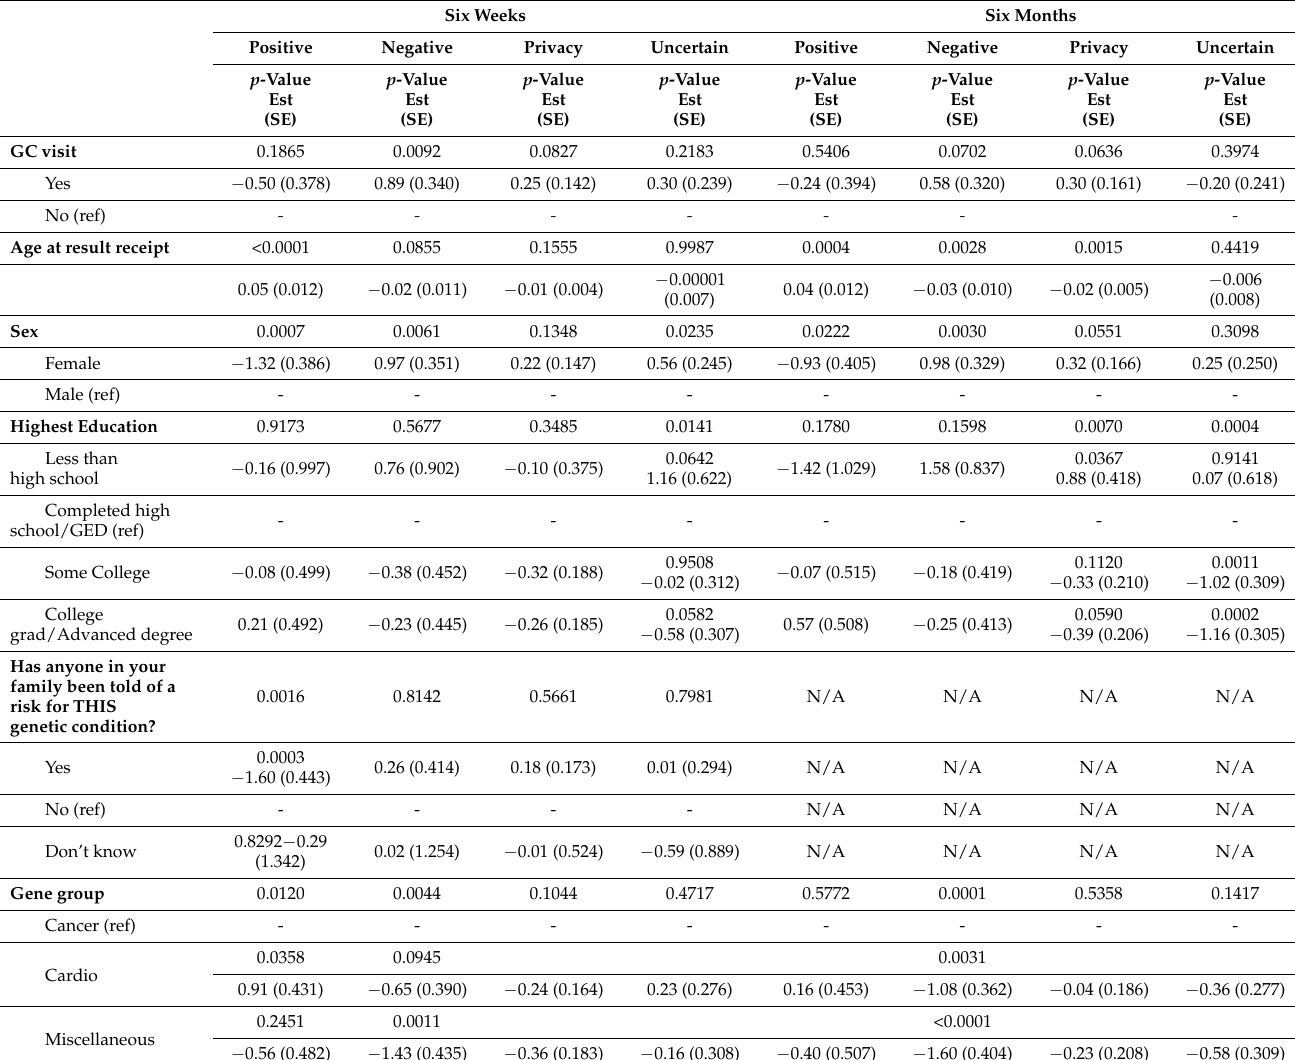
Table 3. General linear model estimates for the FACToR subscales at 6 weeks and 6